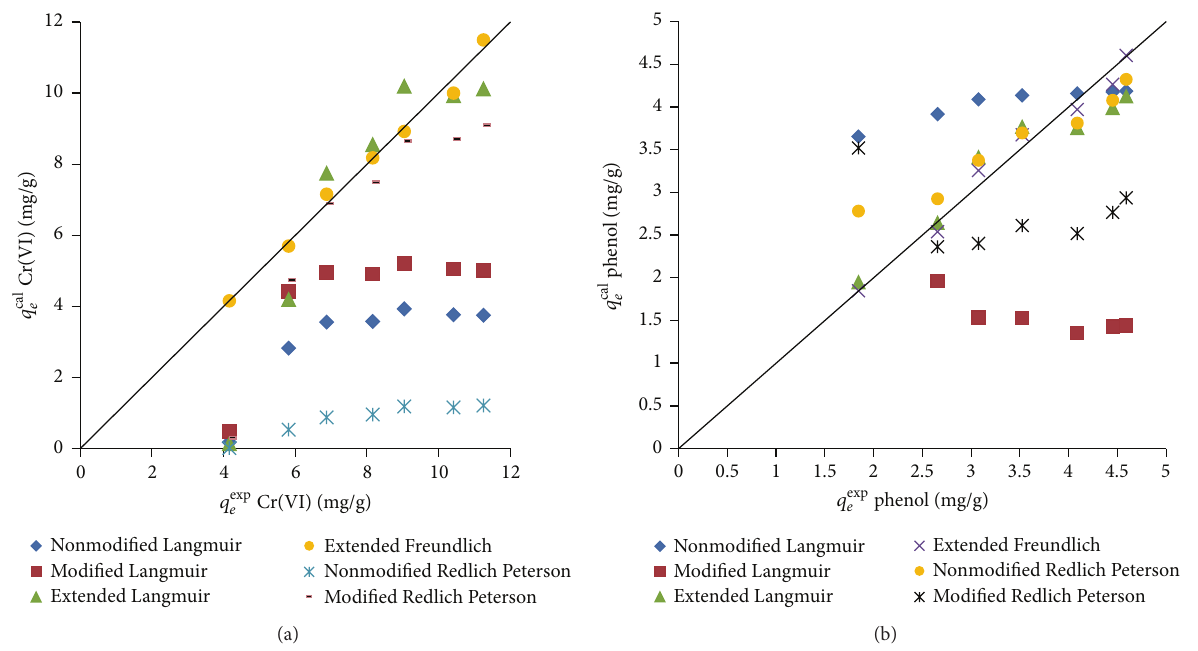
Figure 7: (a) Comparison of experimental and calculated value of 𝑞 𝑒 for Cr(VI) in binary mixture. (b) Comparison of experimental and calculated value of 𝑞 𝑒 for phenol in binary mixture.